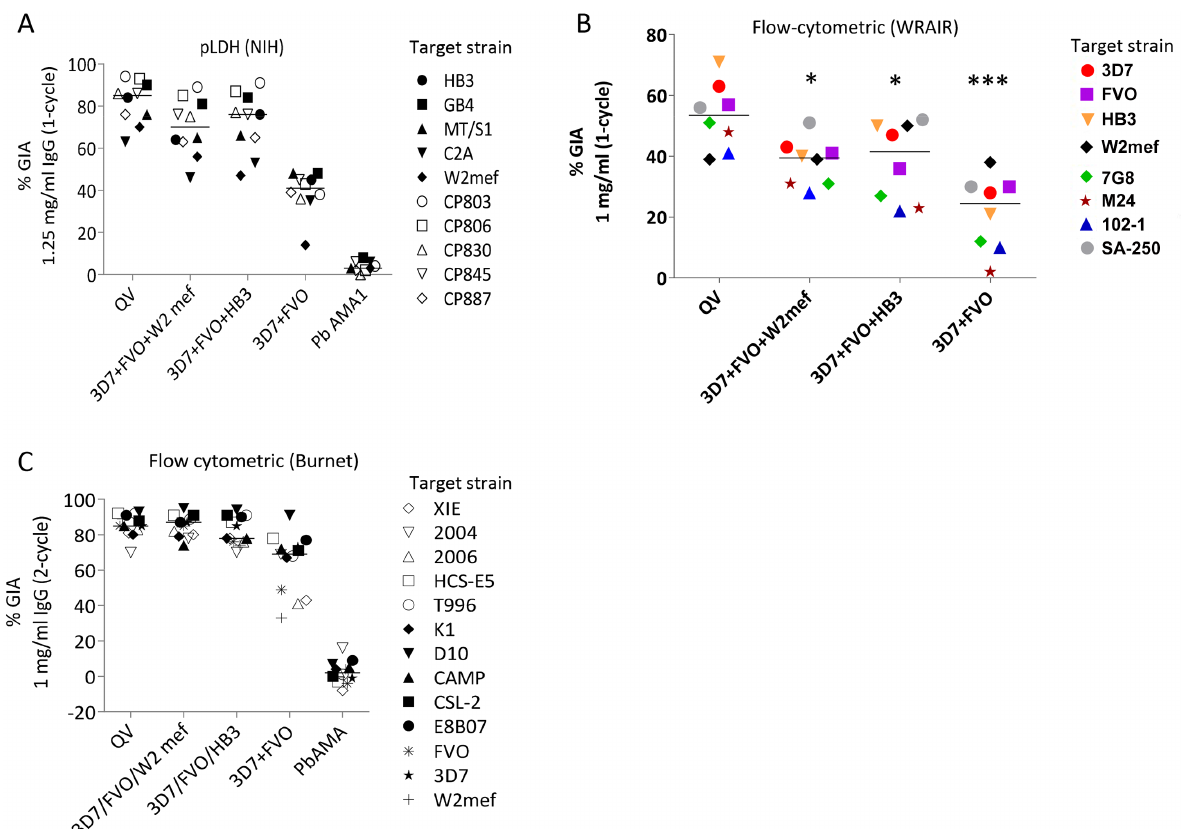
Figure 3. Inhibitory coverage against laboratory and field isolates. ( A ) One-cycle GIA at 1.25 mg/ml total IgG pool from 3 rabbits tested by the NIH pLDH assay. GIA of anti-QV was compared to trivalent and bivalent vaccine groups and antibodies against P. berghei AMA1 (PbAMA1) were tested as the negative control. Strains CP803, CP806, CP830, CP845, and CP887 were recent culture adapted Cambodian isolates and HB3, GB4, MT/ S1, C2A, W2mef were laboratory strains. Lines are median inhibition across strains. ( B ) One-cycle GIA at 1 mg/ml total IgG pool from 3 rabbits conducted by the WRAIR flow-cytometric method against 8 parasite strains. (*) indicates, p , 0.05; (***) p , 0.0001 (corrected for multiple comparisons). ( C ) Two-cycle GIA at 1 mg/ml pooled IgG conducted by the Burnet Institute flow-cytometric method. Strains CSL-2, HCS-E5, 2006, 2004, XIE were recently culture adapted field isolates from Africa, Asia and isolates E8B07, CAMP, D10, K1, T996 were laboratory strains [43].